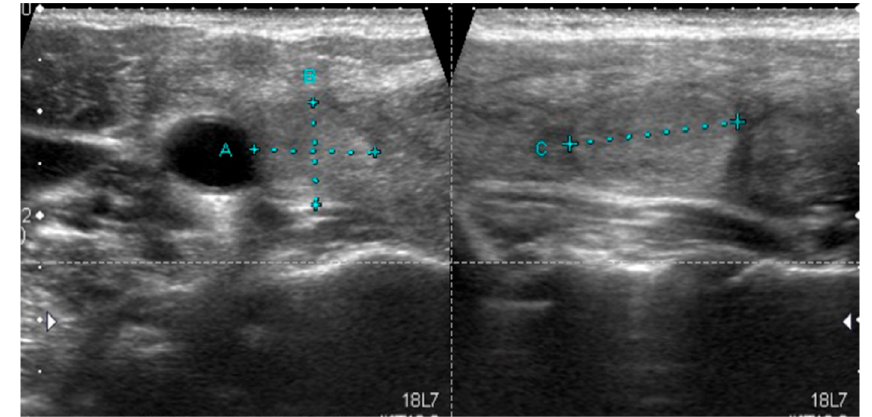
Figure 3. Typical sonographic pattern of RAS -positive NIFTP, normoechoic lesion with well-defined margins and without calcifications.